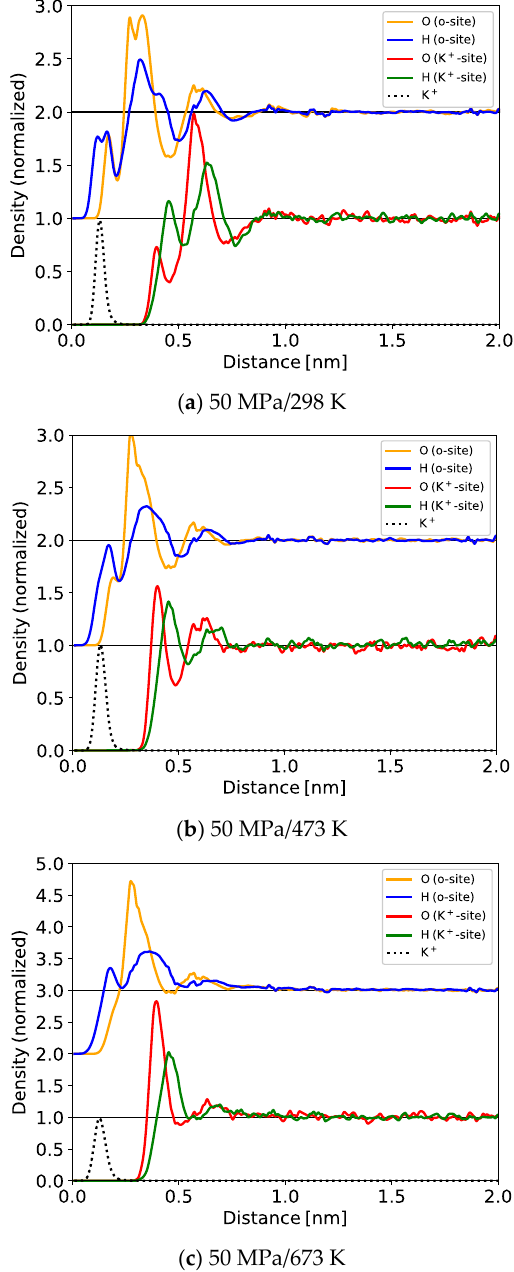
Figure 6. Normalized density profiles of O, H, and K + on K + -site and o-site.